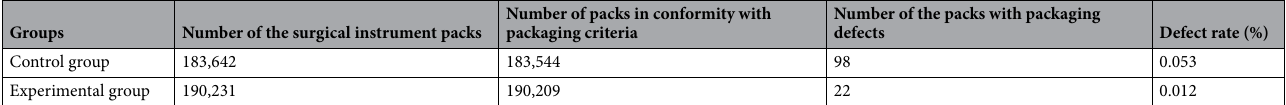
Table 2. Comparison of the defect rates in surgical instrument packaging. χ 2 = 50.822; P =